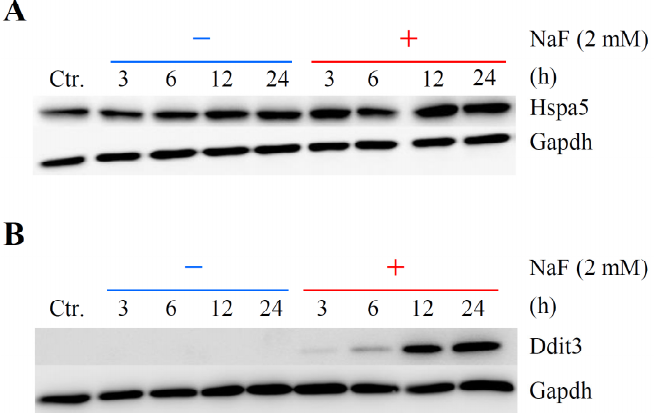
Figure 9. Effects of NaF on protein expressions for Hspa5 and Ddit3 in ROE2 cells. Cells were cultured with or without 2 mM of NaF for 3 to 24 h. Western blot analysis was performed with the specific primary antibodies for Hspa5 ( A ) and Ddit3 ( B ). Gapdh served as a loading control. Ctr., control (non-treated cells).